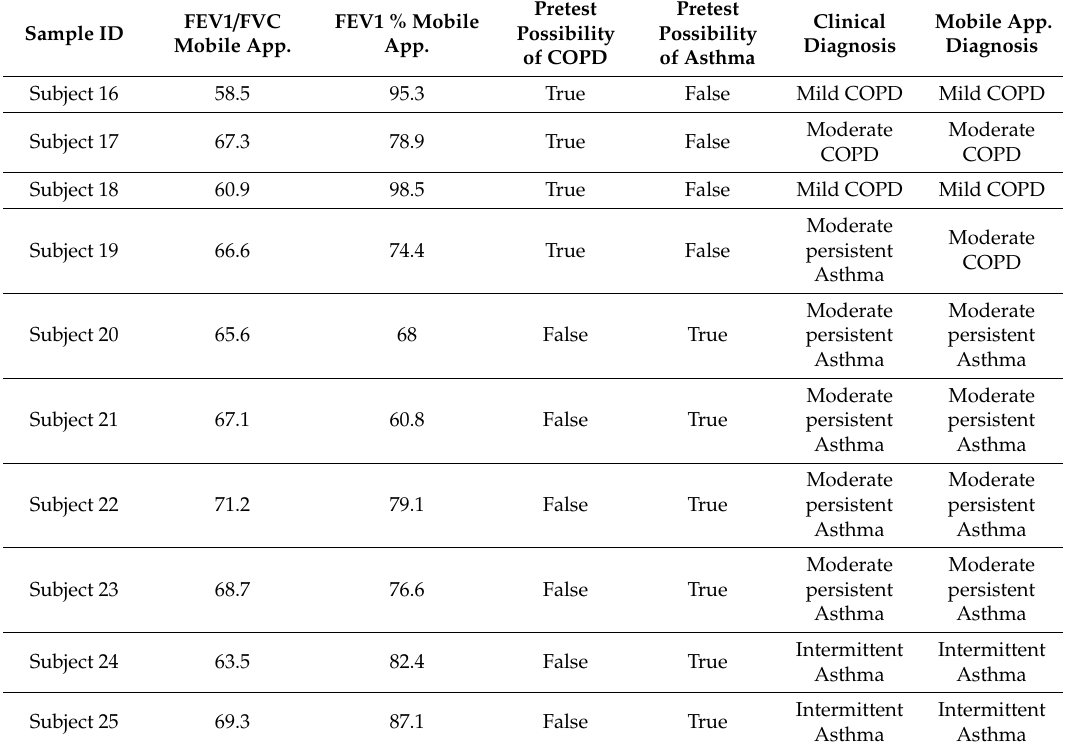
Table 3. Diagnosis Results of the